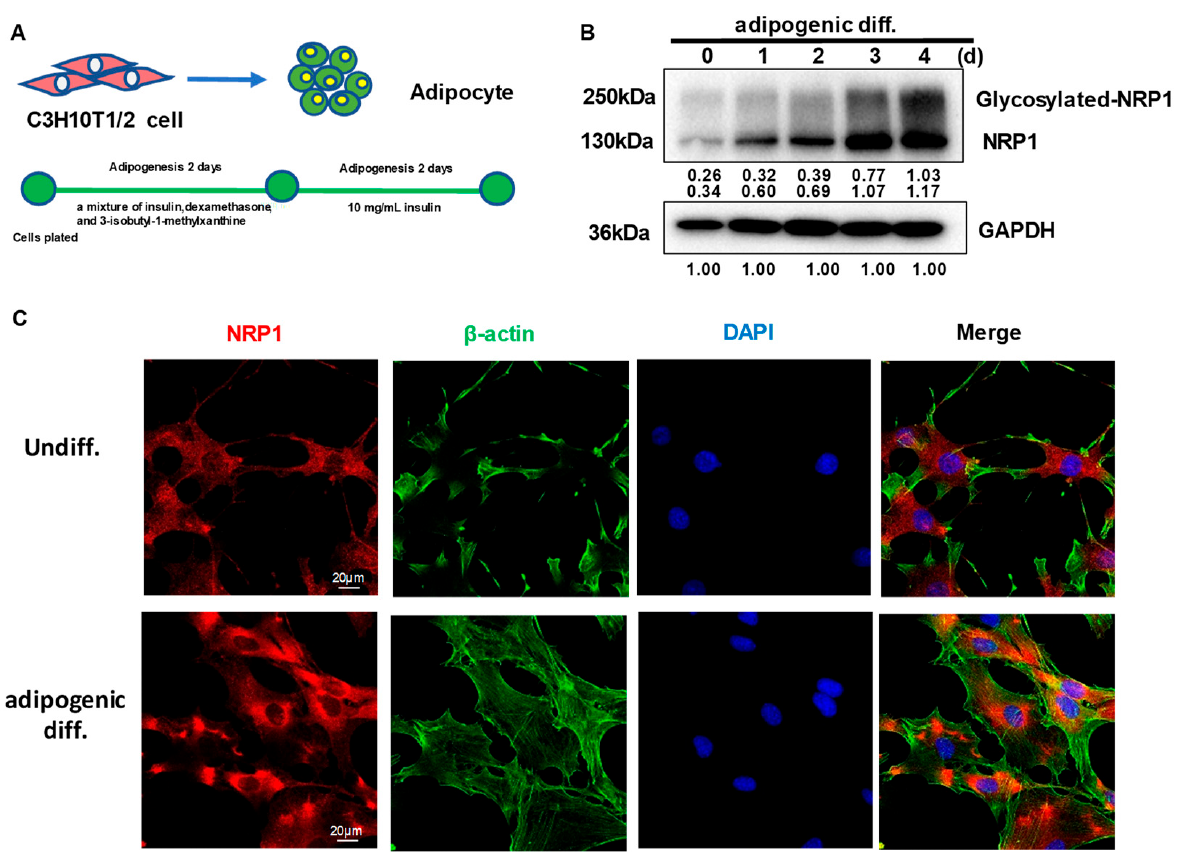
Figure 1. Expression and subcellular localization of NRP1 during adipogenesis in C3H10T1/2 cells. ( A ) C3H10T1/2 cells have the capacity to differentiate into adipocytes. ( B ) C3H10T1/2 cells were cultured in an adipogenic medium for the indicated days; Western blot analysis was performed using anti-NRP1 antibody. ( C ) C3H10T1/2 cells were cultured in an adipogenic medium for three days; immunofluorescence staining and confocal laser scanning microscopy detected NRP1, β -actin, and DAPI. Scale bars, 20 µm. The images are representative of at least three independent experiments.